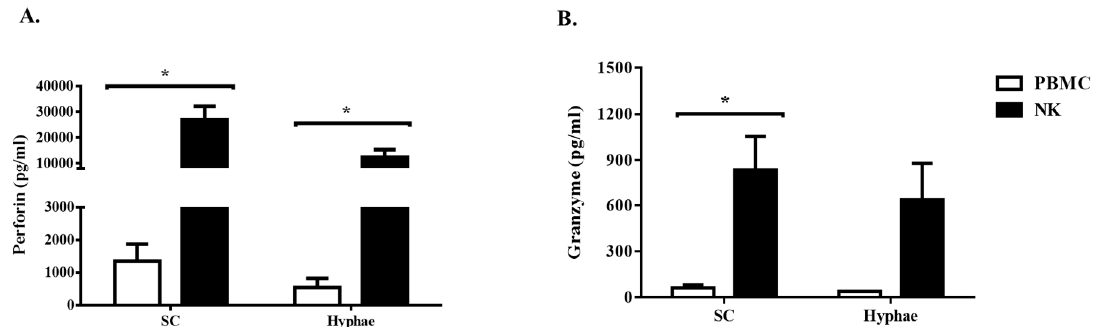
Figure 4. Production of cytotoxic granules by expanded NK cells. ( A )—Perforin, ( B )—Granzyme B in the supernatants of expanded NK cells and PBMC exposed to swollen conidia (SC) and hyphae (H) of A. fumigatus were assessed by ELISA. Data represent the mean of duplicate measurements (± SEM) pooled from 3 experiments. * p < 0.05 compared to PBMC.